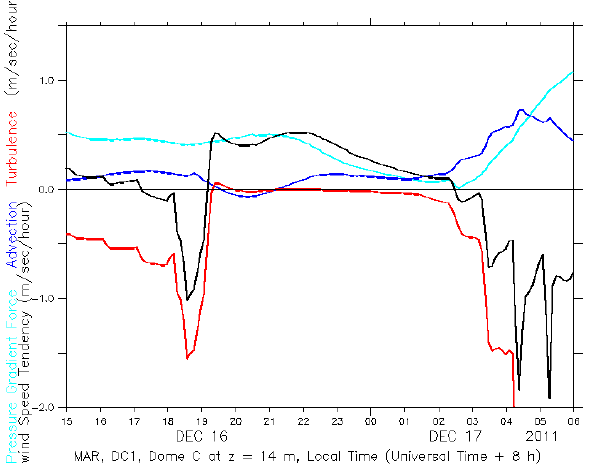
Figure 9. Simulated contribution of the forces to the wind speed, 14ma . g . l . at Dome C on 16–17 December 2011. Local Time LT (Universal Time UT + 8h) is used. The shutdown of turbulence oc- curs at 19:00LT.